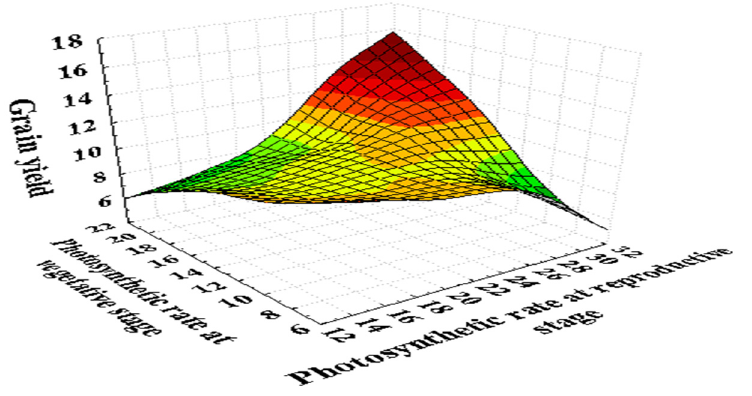
Figure 3. Photosynthetic (µmol m − 2 s − 1 ) response at the seedling and reproductive stage of 180 wheat genotypes with the grain yield per plant (g). Photosynthetic rate was recorded on a clear day between 10:00 a.m. to 12:00 p.m. with the help of infrared gas analyzer (IRGA ADC, LCA-4, Hoddesdon, UK). Data collected under normal and heat stress conditions at the vegetative (Zadoks scale 39) and reproductive stages (Zadoks scale 69) [94]. It represented that the photosynthesis is directly associated with the grain yield at both stages. As the photosynthetic rate decreases, it reduces the grain yield in wheat.